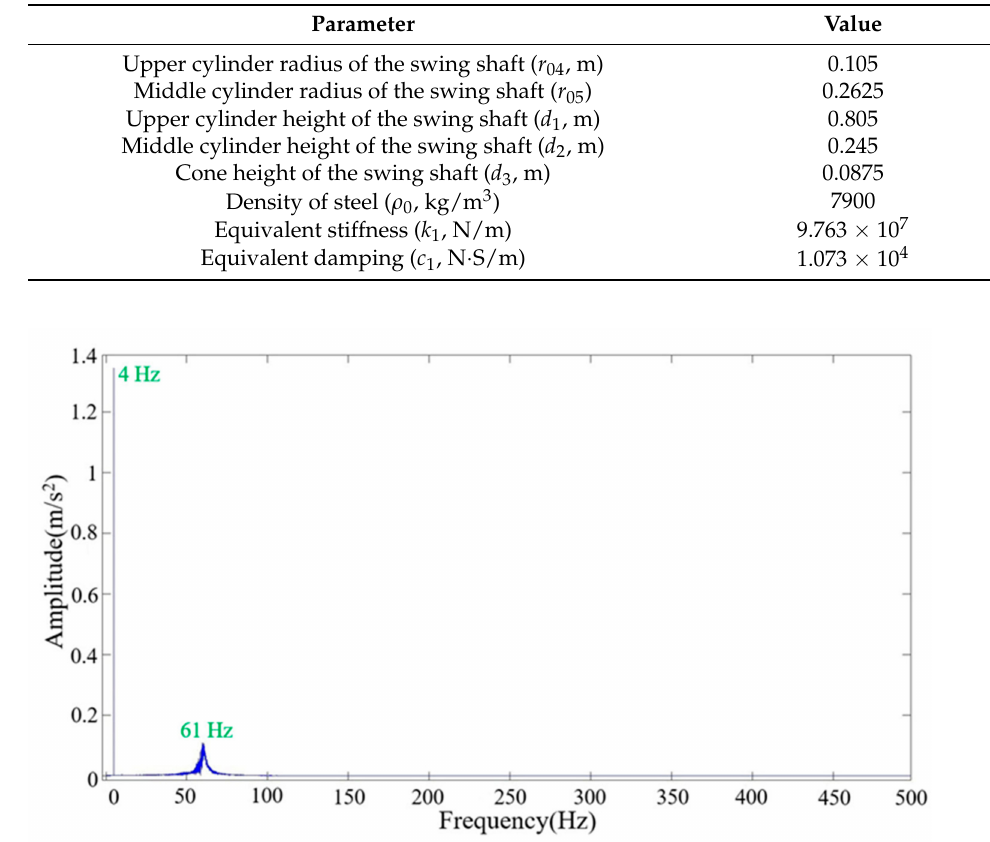
Table 2. Parameters of the 6300 KN COF machine.